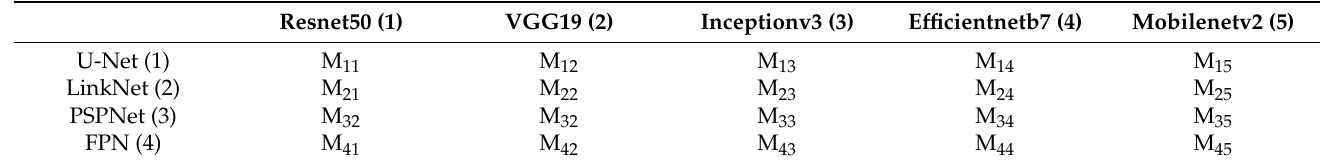
Table 2. Representation of each basic segmentation model with different encoders .